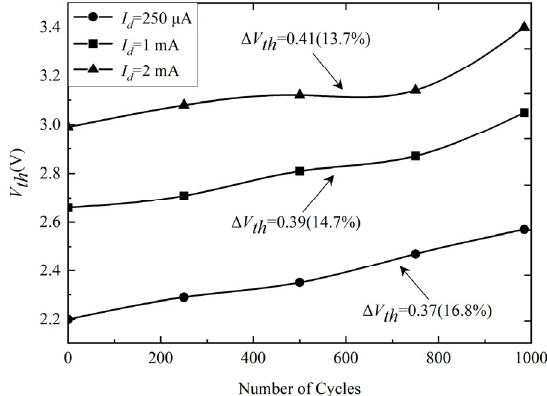
Figure 5. The variation in V th for different drain currents I d .